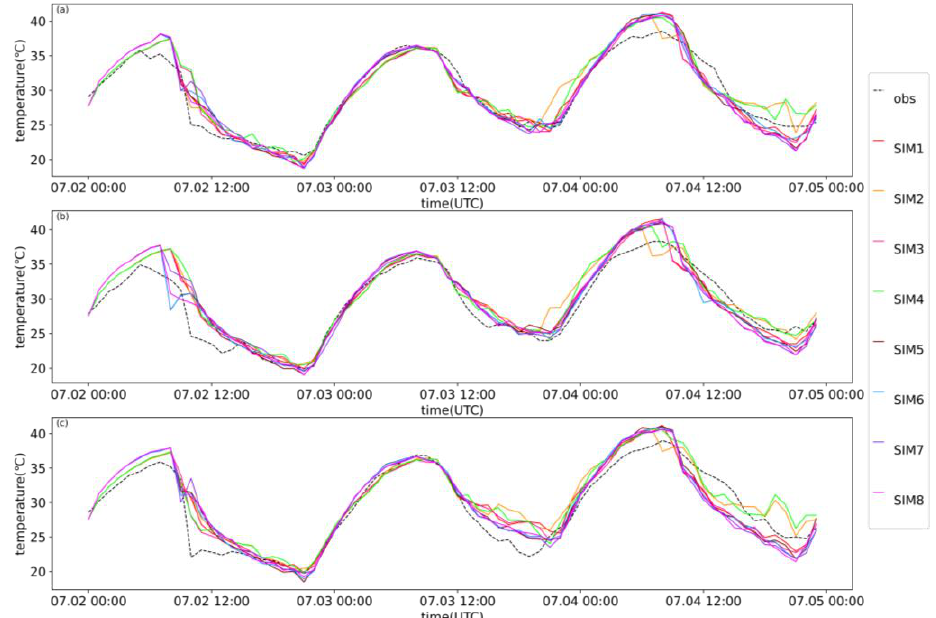
Figure 3. Time series of the observed and simulated 2-m temperatures from 2–4 July at 3 sites: ( a ) Rongcheng: 54,503, ( b ) Xiongxian: 54,636, and ( c ) Anxin: 54,605.